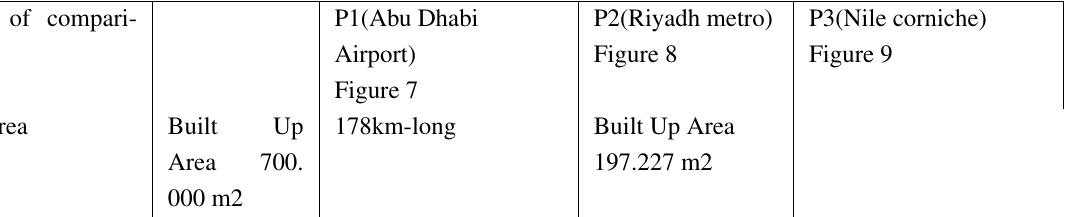
Table 3. Comparison between the previous three case